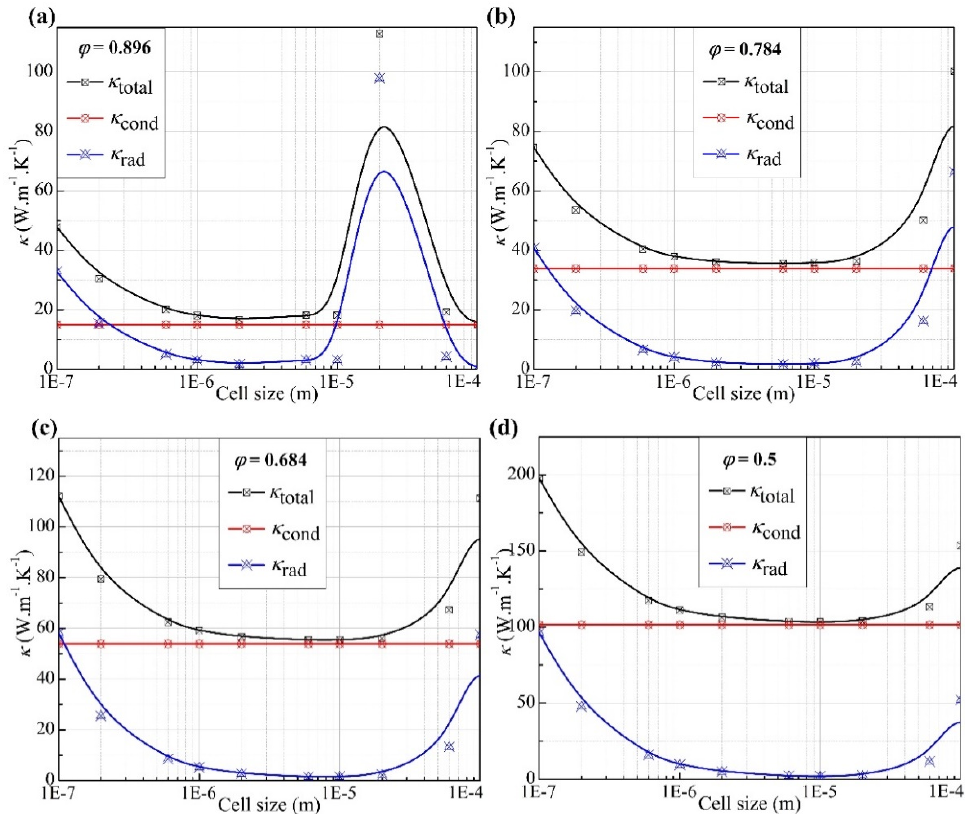
Figure 6. Equivalent thermal conductivity of high-porosity periodic cubic frame silver structure: ( a ) φ = 0.896; ( b ) φ = 0.784;( c ) φ = 0.684; ( d ) φ = 0.500.